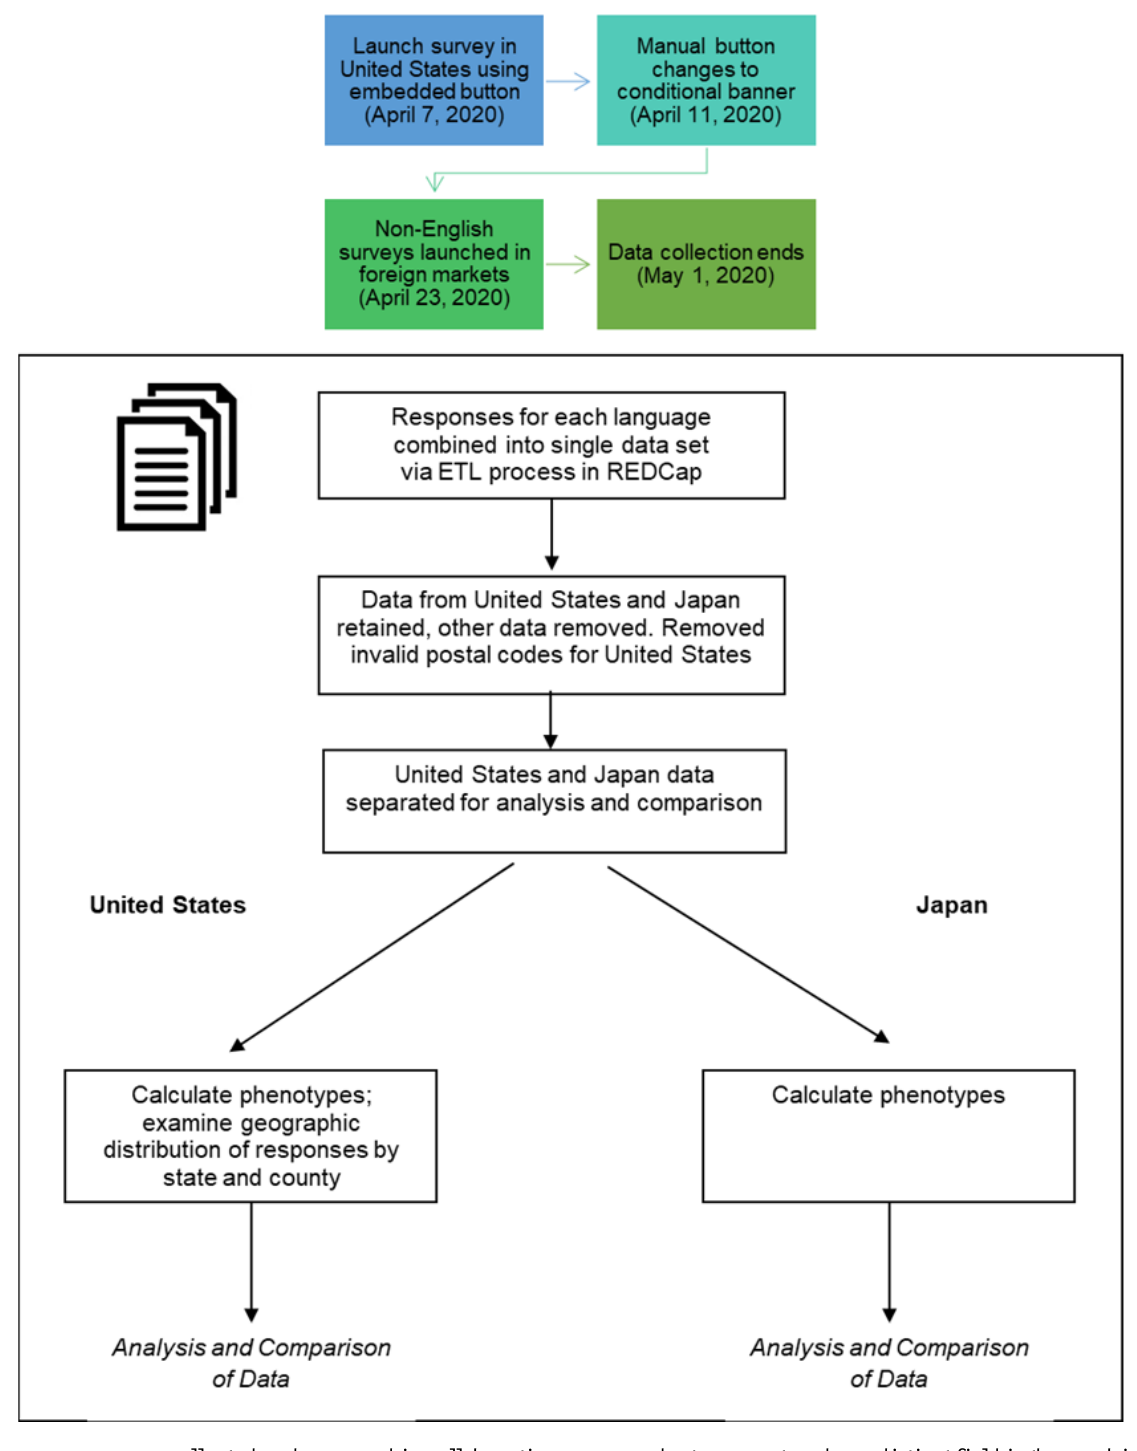
Figure 2. Overview of data collection and analysis processes. ETL: extract, transform, load; REDCap: Research Electronic Data